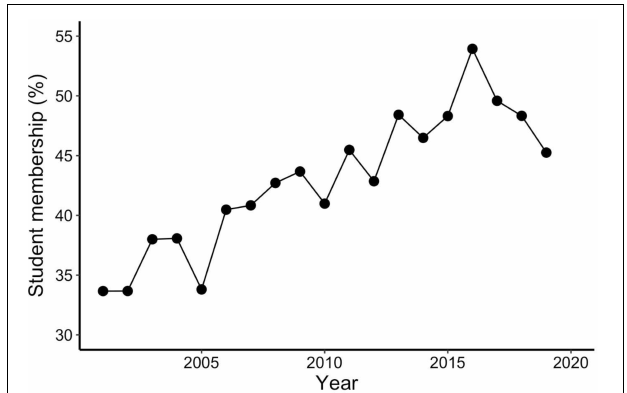
FIGURE 1 | Percent of AES members who had a student